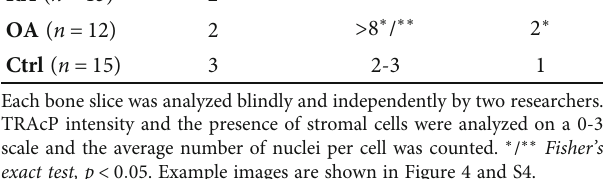
exact test, p < 0 : 05 . Example images are shown in Figure 4 and